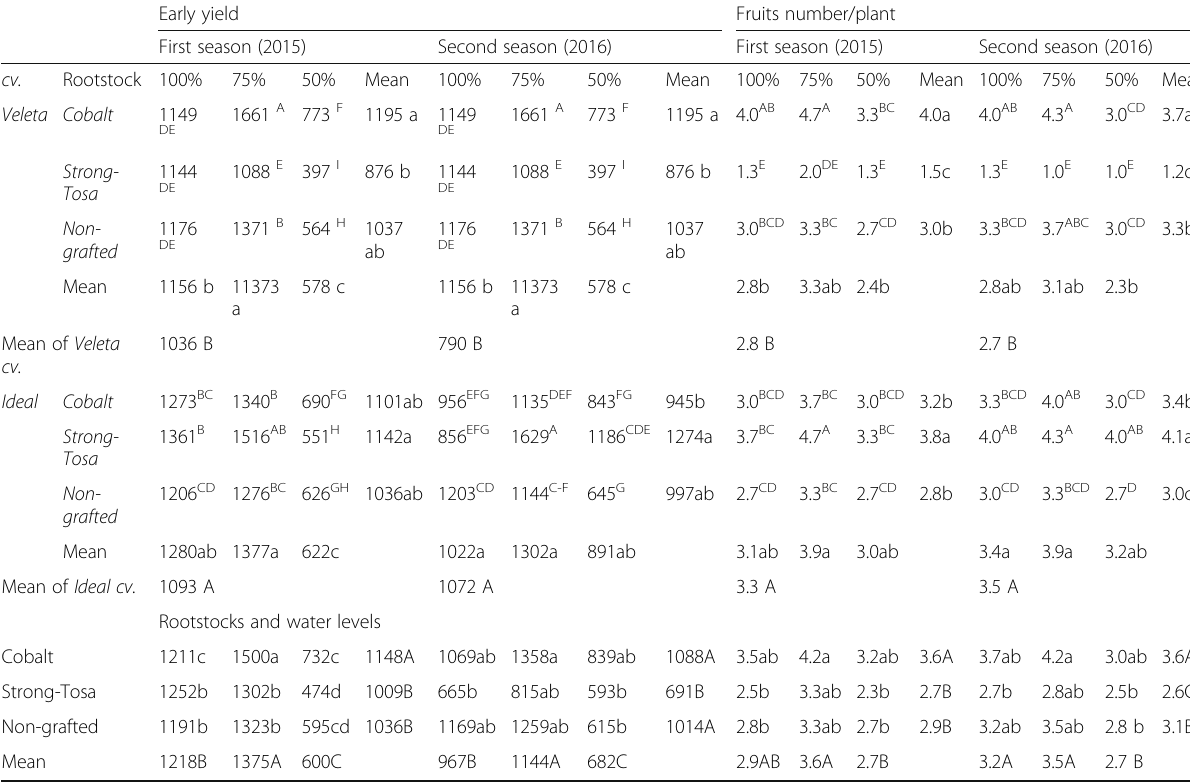
Table 4 Effect of deficit irrigation rates (% ETc), cultivars and rootstocks on early yield (g/plant) and fruits number/plant of cantaloupe plants during 2015 and 2016 seasons Early yield Fruits